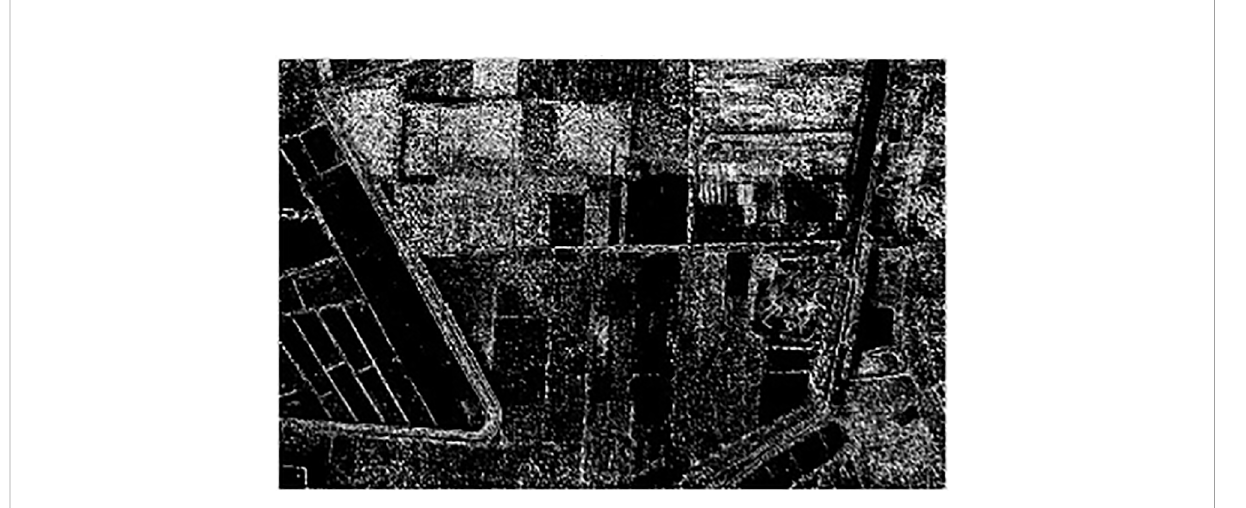
FIGURE 7 Edge detecting based on Sobel.